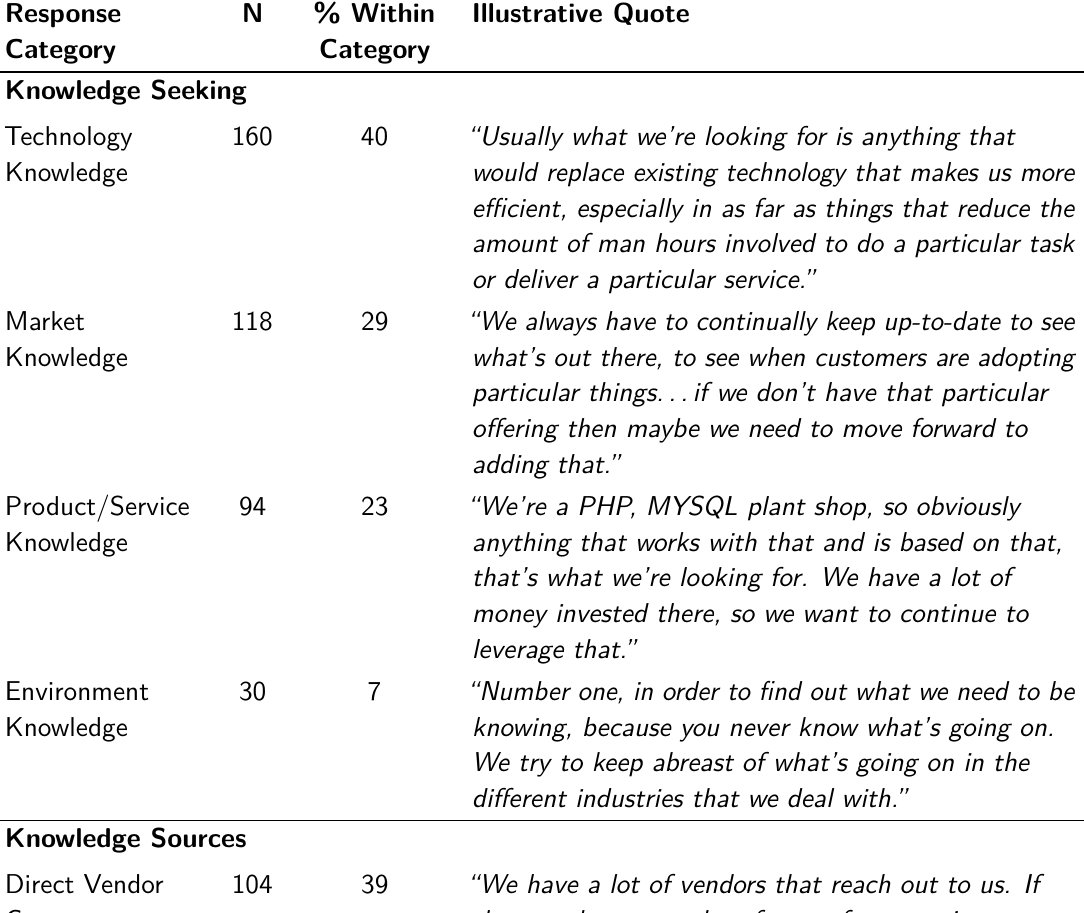
Table 2. Emergent Themes, Frequencies and Illustrative